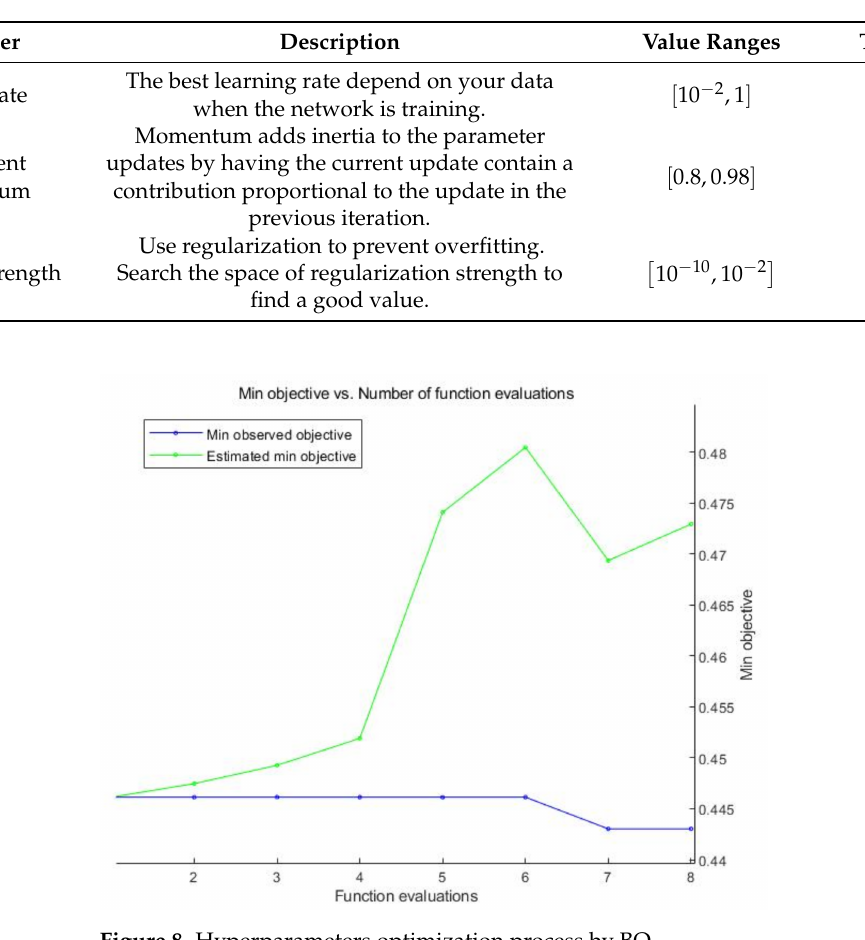
Table 3. The descriptions, value ranges, and the optimal value of hyperparameters by BO used in this study.